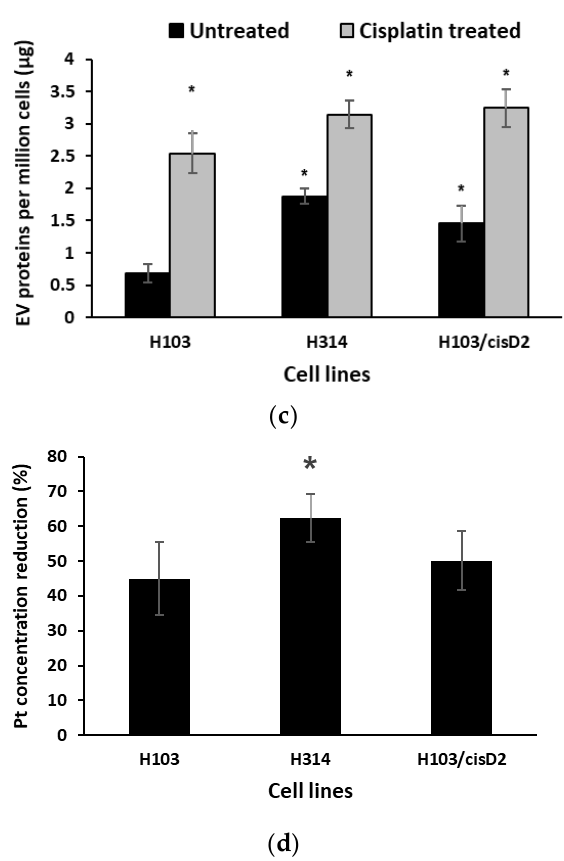
Figure 5. Regulation of drug resistance-associated proteins in OSCC cell-derived EVs. ( a ) Western blot images of ATP1B3 expression in OSCC cells and EVs. Signals of EV proteins were normalized against intensity of HSC70 while those of cell lysate were against actin. ( b ) Quantification of ATP1B3 expression level in EVs and cell lysates. ( c ) EVs production by OSCC cells with and without cisplatin treatment. ( d ) Percentage of cisplatin reduction in OSCC cell lysate within 10 h after treatment. * indicate significant differences, n = 3, p < 0.05 (One-way Annova, Tukey’s post-hoc).